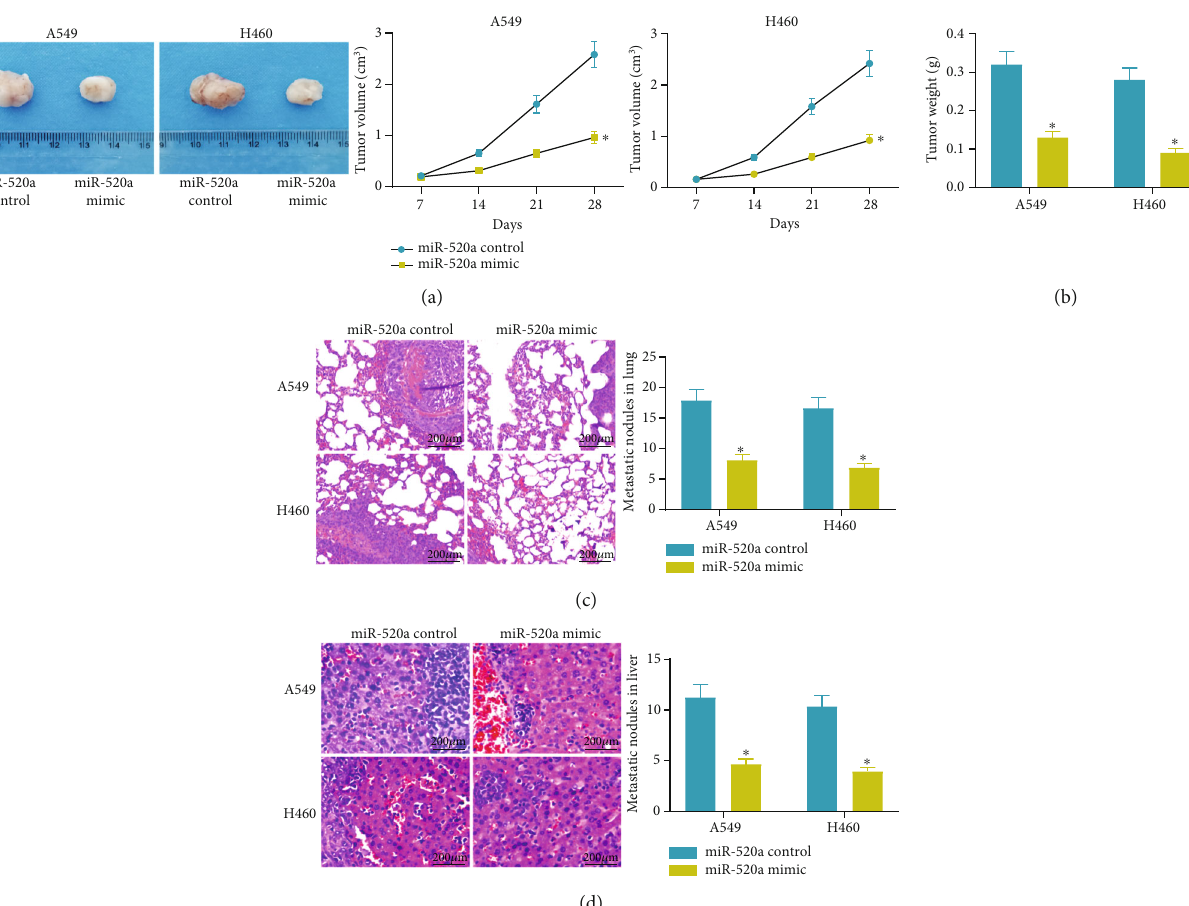
Figure 5: miR-520a inhibits tumor formation and metastasis in nude mice. (a) Role of miR-520a mimic in tumor volume changes ( ∗ p < 0 : 05 , two-way ANOVA). (b) Role of miR-520a mimic in tumor weight change ( ∗ p < 0 : 05 , two-way ANOVA). (c, d) Formation of metastatic nodules in lung (c) and liver (d) nodules in rats ( ∗ p < 0 : 05 , two-way